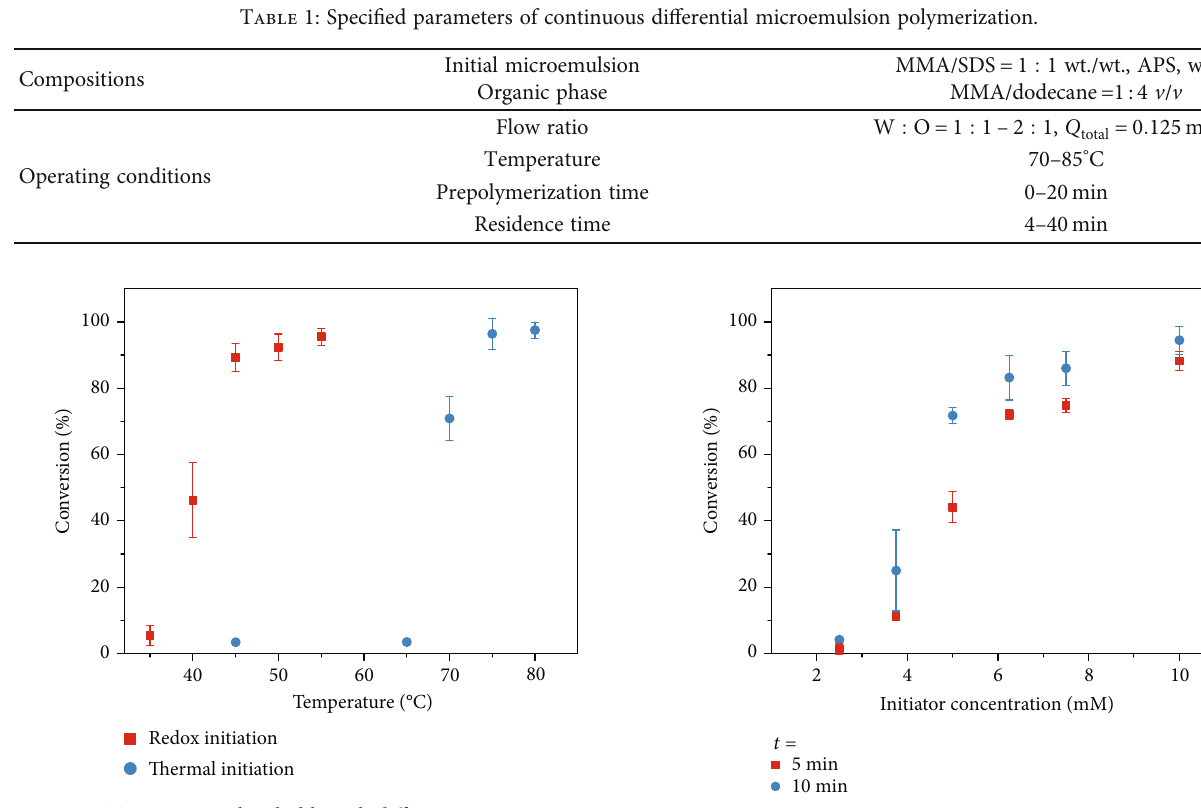
Figure 3: E ff ect of the initiator concentration on the MMA conversion at 70 °